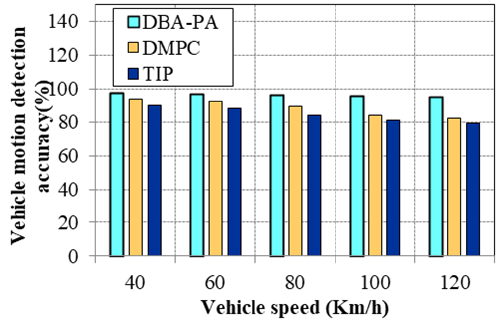
Figure 8. Vehicle Speed vs. Vehicle-Motion Detection Accuracy.